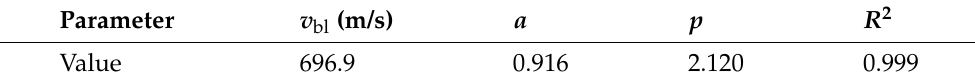
Figure 2. Residual velocity as a function of impact velocity. Table 4. Values of Recht-Ipson parameters for the AZ31B Mg plate under